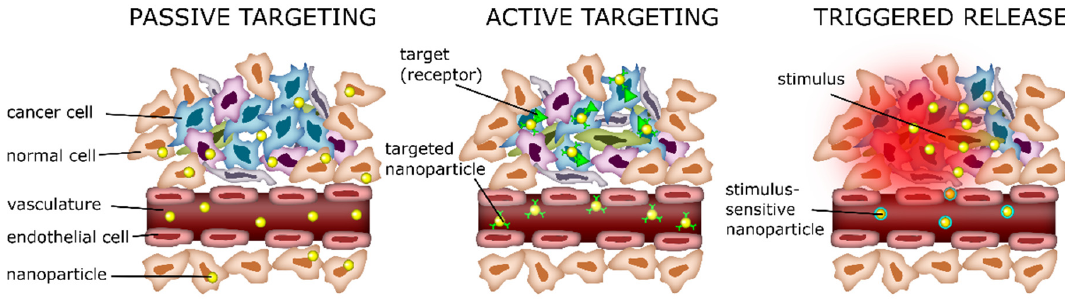
Figure 1. Comparison of passive targeting, active targeting, and triggered release of nano-drugs. Tumor cells overexpress specific receptors on their surface. Active targeting exploits the overexpression of specific ligand-binding receptors in tumor tissues (Figure 1). These ligands are attached on the surface of drug-loaded nanocarriers which has significant af- finity with overexpressed receptors of tumor site [12]. Choice of ligands is usually critical in appropriate binding with receptors to deliver higher amount of drug to cancer cells rather than in healthy tissues. Several ligands have been exploited in active targeting of drug delivery including peptides (e.g., glycine, asparagine, arginine, octreotide), [32], pro- teins (e.g., antibodies, transferrin, growth factors), mono- and polysaccharides (e.g., ga- lactose, hyaluronic acid), and aptamers (e.g., biotin, bisphosphonates) [33]. Active target- ing has several advantages over passive targeting such as lower systemic administration, higher efficacy, and higher delivery of therapeutic drug [12,13]. Some tumor cells highly express integrin α v β 3 receptors [11] that actively bind with cyclic peptide iRGD (tumor- penetrating and tumor-homing peptide), exhibited enhanced tumoricidal effects of doxo- rubicin [32]. Overexpression of transferrin receptor 1 on tumor cells can potentially be exploited by transferrin-conjugated NDDs [34]. High dose of transferrin conjugated NDDs was also found toxic to normal cells, as well [35]. EGFR (epidermal growth factor receptor) conjugated NDDs via endocytic pathway, unlike transferrin receptor 1, promote the transportation of drug into the nucleus in rapidly dividing cells [36]. ErbB2 (erythro- blastic leukemia viral oncogene homolog 2) is overexpressed in breast carcinomas. F5- scFv containing doxorubicin exhibited antitumor activity and significant reduction in tu- mor size of xenografted mice [37]. Treatment of malignancies with VEGF (vascular endo- thelial growth factor) inhibitors are under clinical trials. Bevacizumab, Avastin ® (anti- VEGF monoclonal antibody), got approval from FDA for the treatment of colorectal can- cer with conventional chemotherapy [38,39]. There are several disadvantages of these NDDS including: (i) Their therapeutic effect might be altered if bounded antibody (ligand) is not degraded properly; (ii) if the fractions involved in antibody-DDS binding are steri- cally hampered then affinity between antibody and NDDS might be; (iii) they are poorly immunogenic and readily excreted via liver and kidneys; (iv) their synthesis is quite ex- pensive; (v) these are degraded by peptidase enzymes and make them biologically inef- fective [5]. Triggered release depends on biological and physical stimuli and can modulate the release of payloads in tumor macroenvironment. pH, temperature, physical, and chemical properties of nanomaterials make nanoparticles to modulate the active/passive delivery of chemotherapeutic drugs and promote their accumulation in the tumor sites (Figure 1). 4. Commonly Used Nano-Drug Delivery Systems in Anticancer Therapy Despite having several limitations, chemotherapy is a widely used treatment ap- proach for cancer. Chemotherapeutic drugs are mostly administered intravenously, and they are highly cytotoxic to normal cells. Targeted delivery of anticancer drugs through nanocarriers is an emerging technology, which commits to overcome drawbacks of chem- otherapy in cancer treatment. Nanosized anticancer particles (anticancer drug loaded)